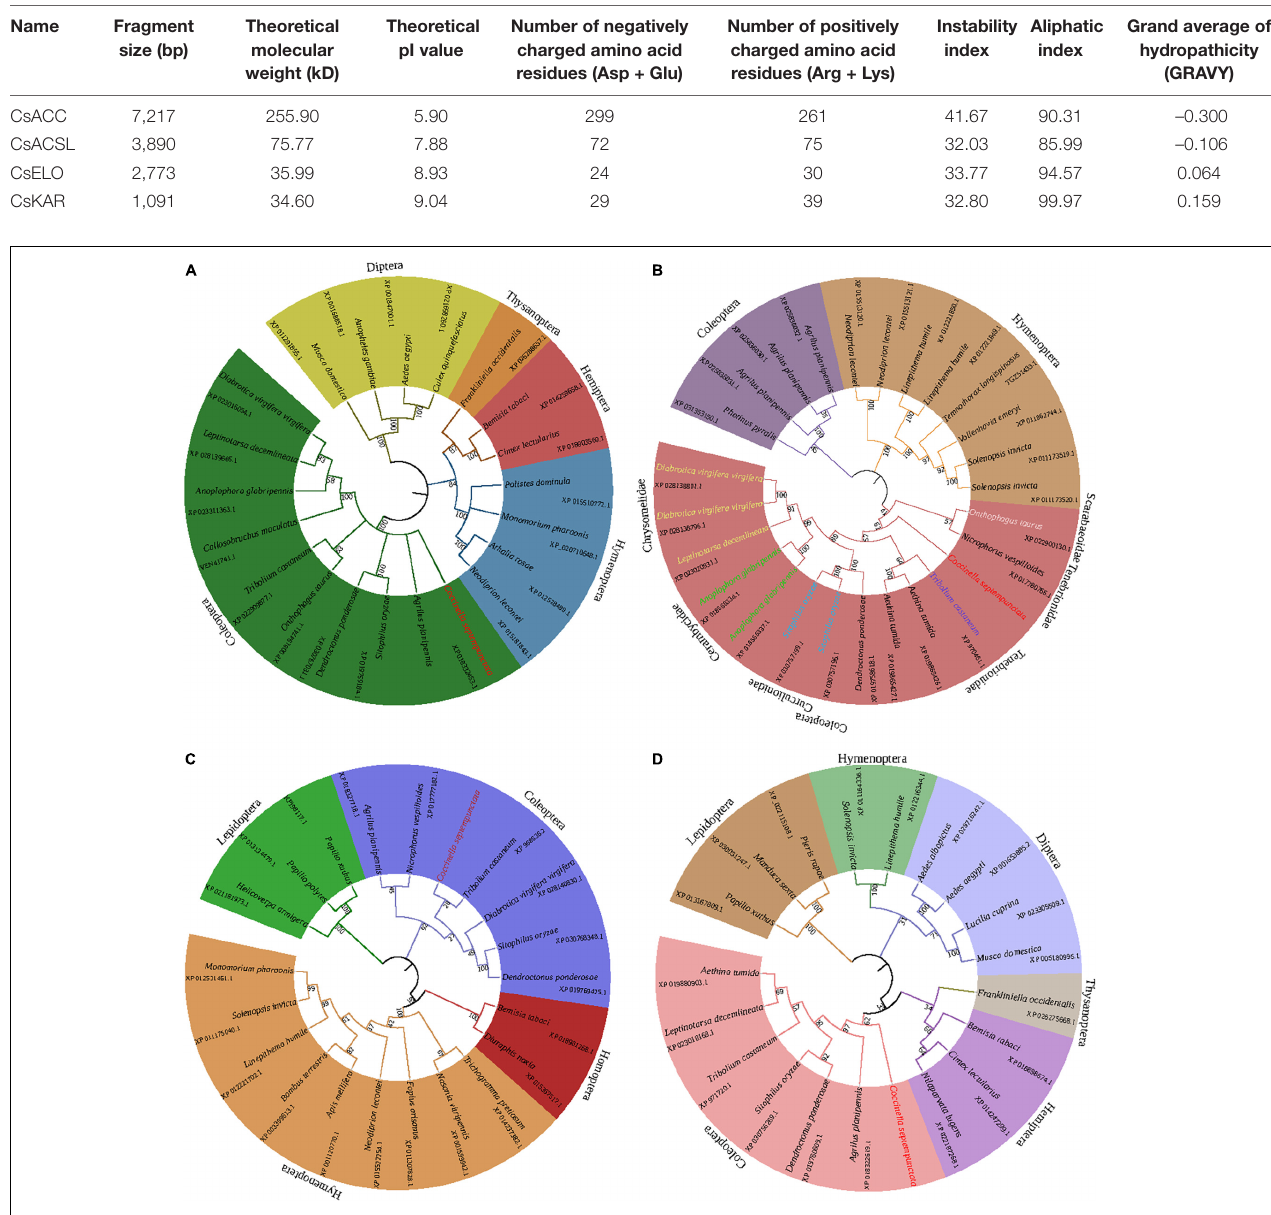
TABLE 2 | Physicochemical properties of CsACC, CsACSL, CsELO, and CsKAR.